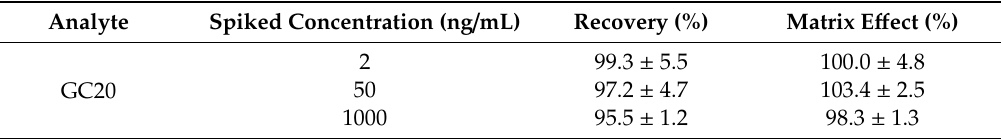
Table 3. Extraction recovery and matrix e ff ect of GC20 in rat plasma (n = 6).